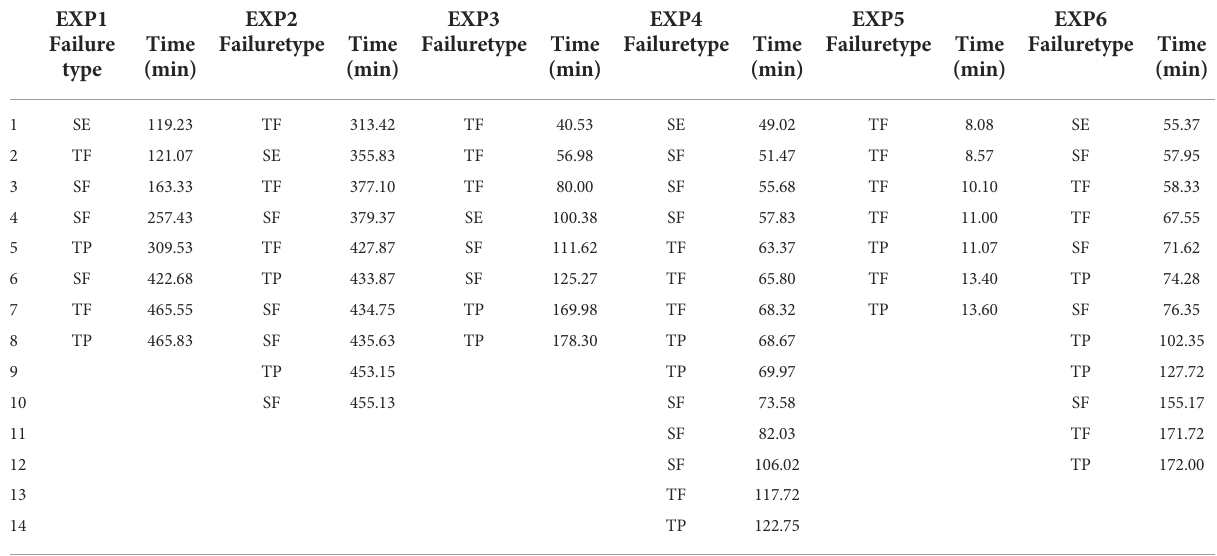
TABLE 4 Summary of failure types and time in each experiment.